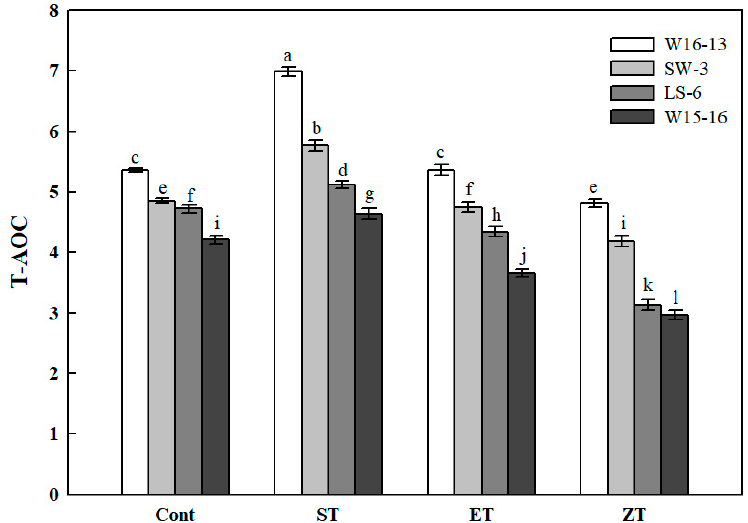
Figure 11. Effects of cold stress on total antioxidant capacity (T-AOC) in four wucai genotypes. Values represent the mean SE ( n = 3). Values with the same letter are not significantly different at the p < 0.05. Cont: 25/18 °C (d/n); ST: 16/10 °C (d/n); ET: 8/2 °C (d/n); ZT: 0/ − 6 °C (d/n).